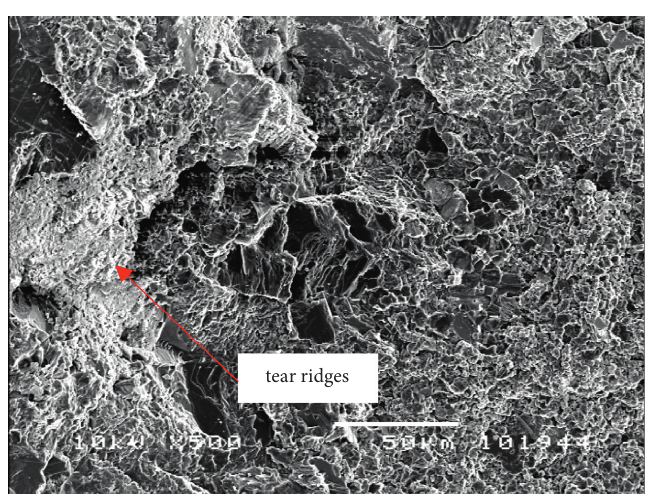
Figure 22: Torn edges on the fracture